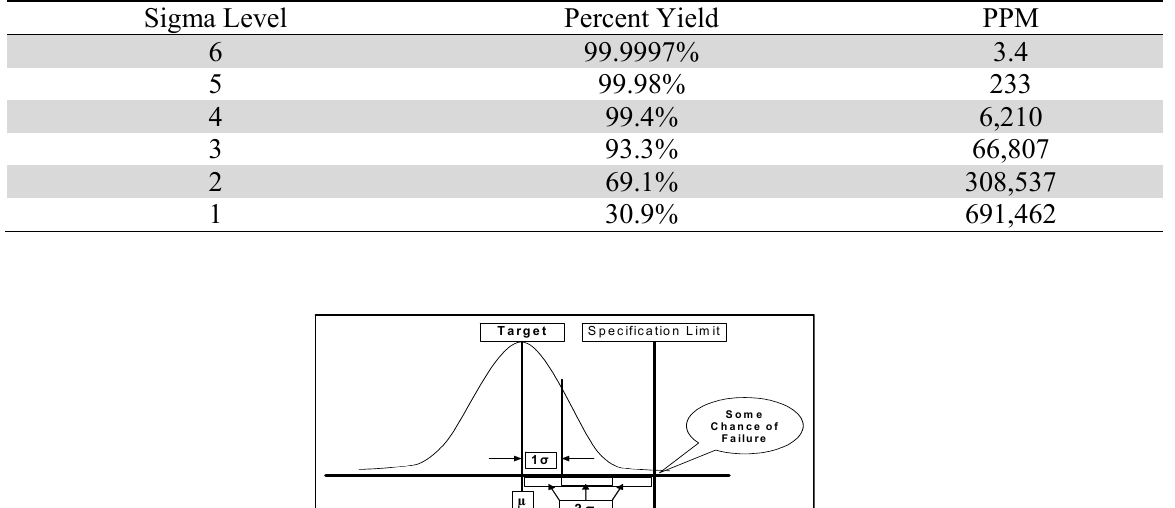
Sigma and Corresponding PPM